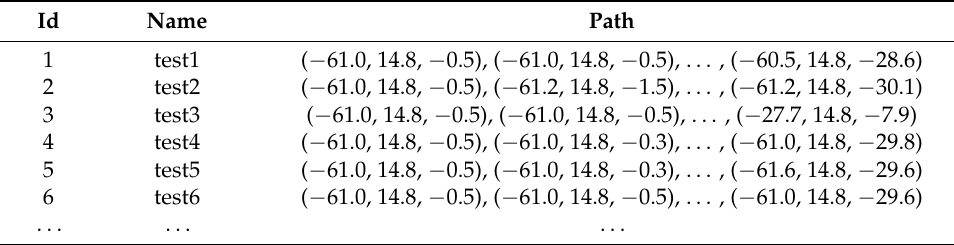
Table 2. The data of evacuation